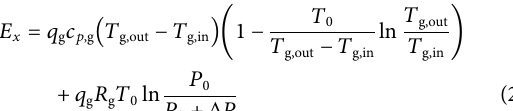
The sinter vertical cooling process is calculated by the numerical model. Taking the multi-size sinter with the equivalent particle diameter of 11.45 mm as an example, Figure 9 analyses the temperature fi eld of the sinter and gas. First of all, it is observed that the gas temperature increases from 293 K to 935.79 K from the bottom to the top of the bed. 341.10 K from the bed top to the bed bottom. There exists the